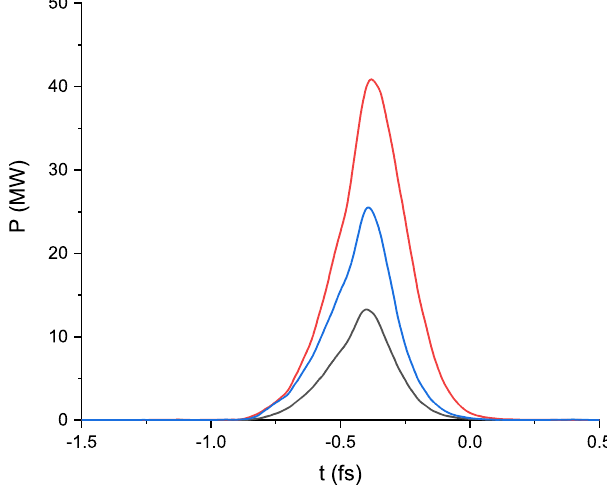
FIG. 5. Radiation power for four representative shots at 4.7 nm. Bunch head is on the left side.